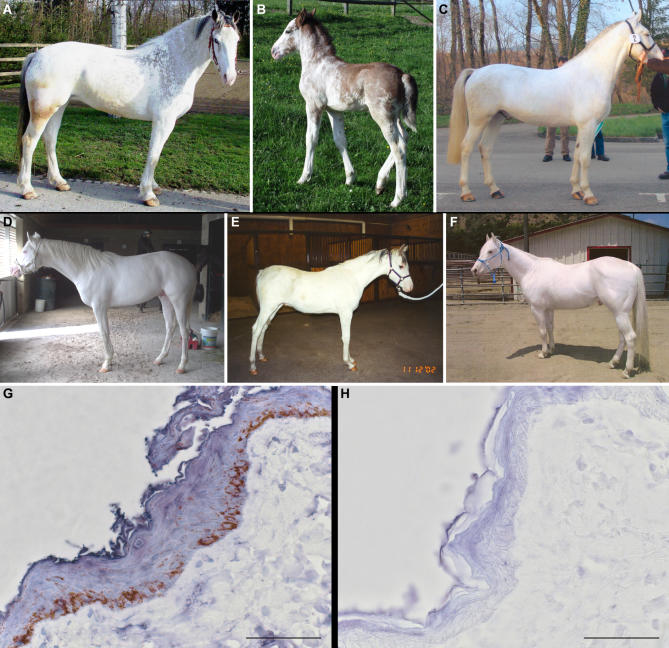
Dominant White Phenotype in Horses(A) Franches-Montagnes mare with little residual pigmentation.(B, C) Dominant white Franches-Montagnes stallion showing partial depigmentation as a colt and almost complete depigmentation at 4 years of age.(D) Dominant white Thoroughbred stallion.(E) Dominant white Arabian stallion.(F) Camarillo White Horse.(G) Immunohistochemistry using a polyclonal KIT antibody on a skin biopsy from a solid-colored horse. Blue staining indicates KIT expression throughout the epidermis. Melanin produced by melanocytes is visible as brown granules.(H) Immunohistochemistry on a skin biopsy of a white horse. Note the weak blue staining and the complete absence of melanocytes and melanin. The bars correspond to 50 μm.